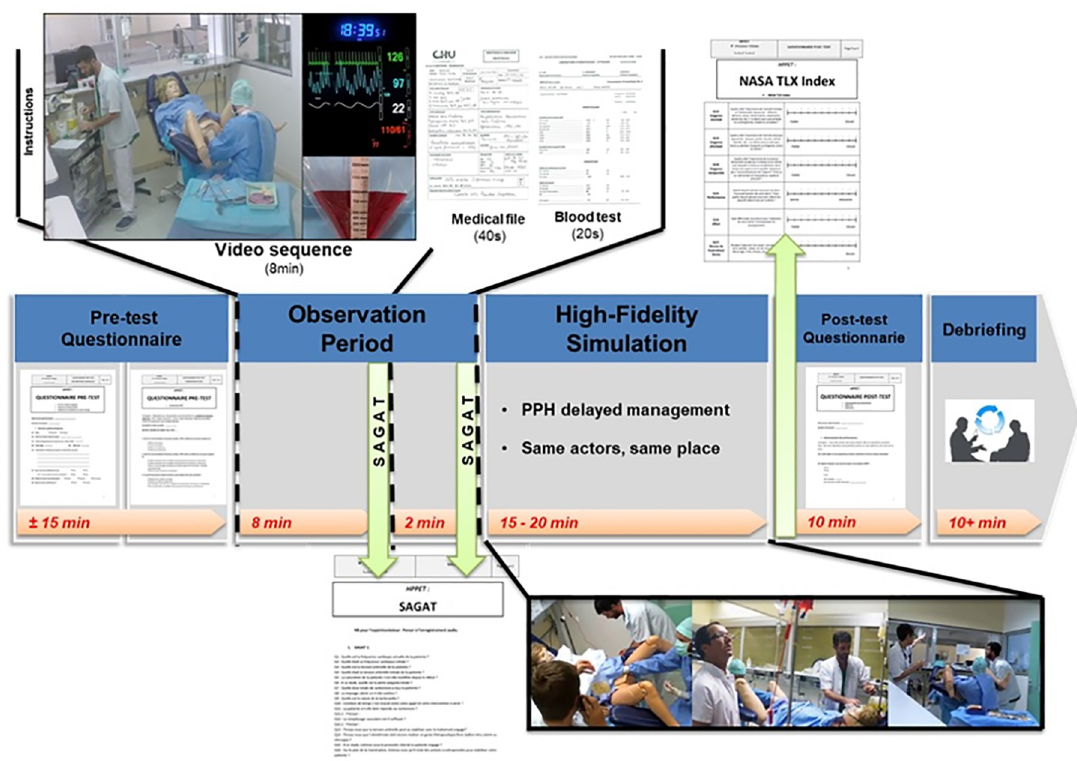
Fig 1. Description of the experimental protocol. First a pretest questionnaire is performed, it characterizes the physicians’ professional experience and the medical knowledge on PPH. After instruction slides, a video clip is presented to the anesthetist for oculometry. The story began at 6:30 p.m., he received a phone call from the nurse for a PPH in progress. The PPH situation presented on the screen (upper banner) showed Noelle 1 , the nurse and the obstetrician during the first 15 minutes of management without the anesthetist. The standardized environment is equipped as a conventional delivery room. The severity of PPH and the actors’ contemplative attitude associated with the inefficiency of the first treatments contributed to the clinical degradation of the patient. A SAGAT is performed at the end of the video. The questions concerned the hemodynamics profile, therapies already undertaken, and the complications envisaged for the patient. Then he had 40 seconds to consult the anesthesia file and 20 seconds to consult the blood test. Another SAGAT is then performed. The questions concern its HPP risk factors and its anesthetic management conditions (allergic risk, risk of difficult intubation, transfusion management). The anesthetist was then asked to manage the patient in the same simulated environment (lower band). Management must be intensive, but the situation was getting worse. The decision of hemostasis surgery marked the end of the scenario. A post-test self-assessment questionnaire and a NASA TLX Index conclude the